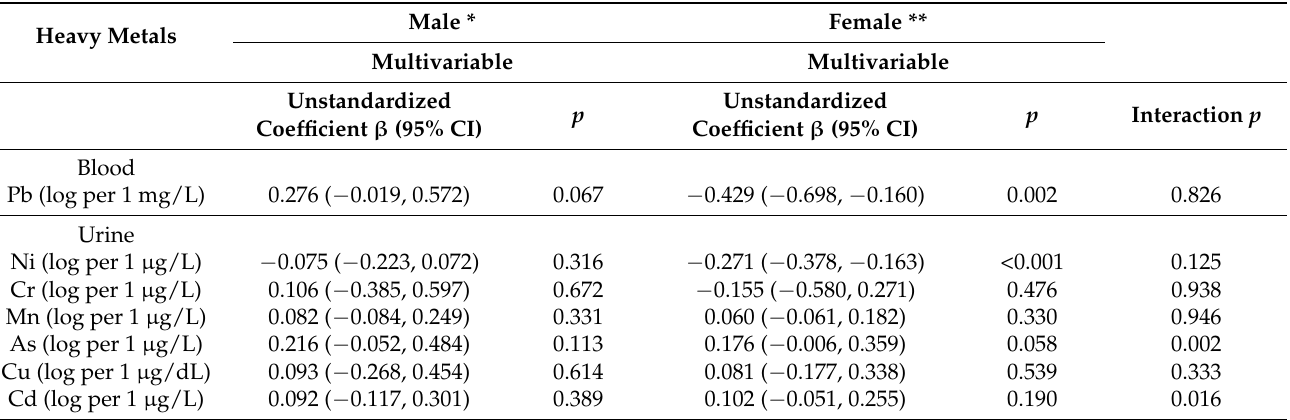
Table 3. Association of heavy metals with Hgb using multivariable linear regression analysis by